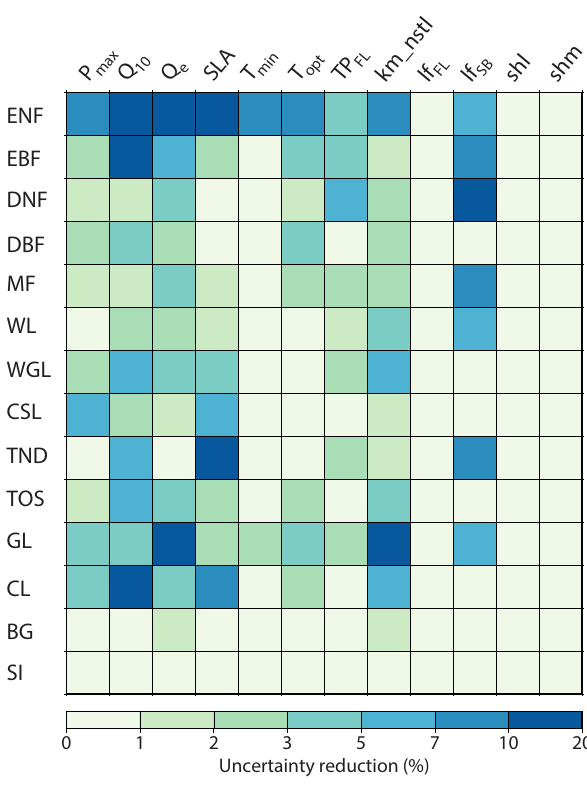
Figure 7. Differences between the posterior parameters (PRM pst ) and the prior parameters (PRM pri ), with uncertainties of prior pa- rameters (UNC pri ) as ( PRM pst − PRM pri )/ UNC pri .